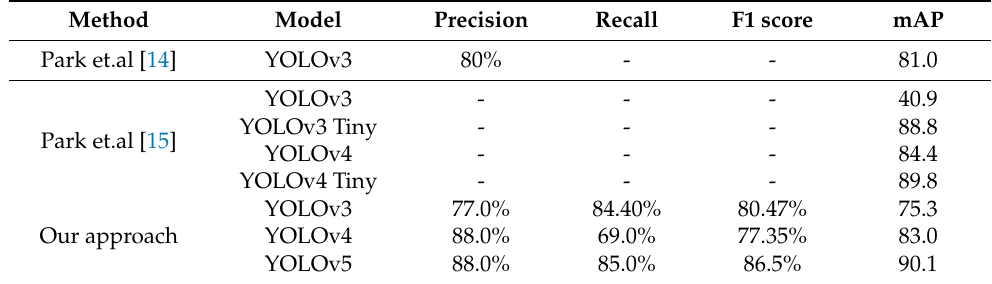
Table 3. Comparative analysis of our approach with other research works based on the state-of-the art.